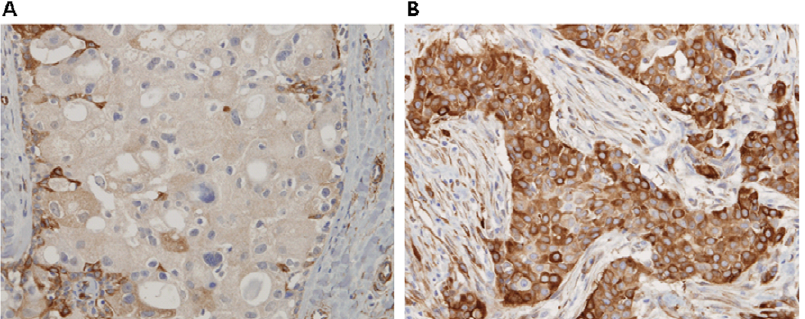
Figure 2. A and B were representative staining for class III beta tubulin in invasive carcinoma of the mammary gland; absence of staining (A), and strong staining(B).